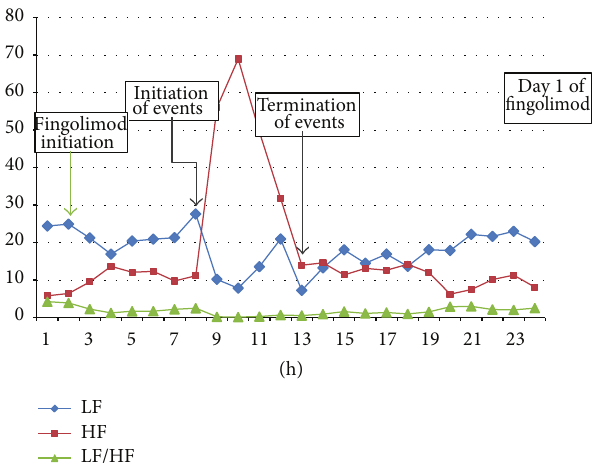
Figure 2: Patient’s heart rate variability analysis of the frequency domain during the 1st day of Fingolimod. Low frequency (line with rhombi) implying cardiac sympathetic tone, high frequency (line with rectangles) implying parasympathetic tone, and the ratio of them (line with triangles) implying ANS